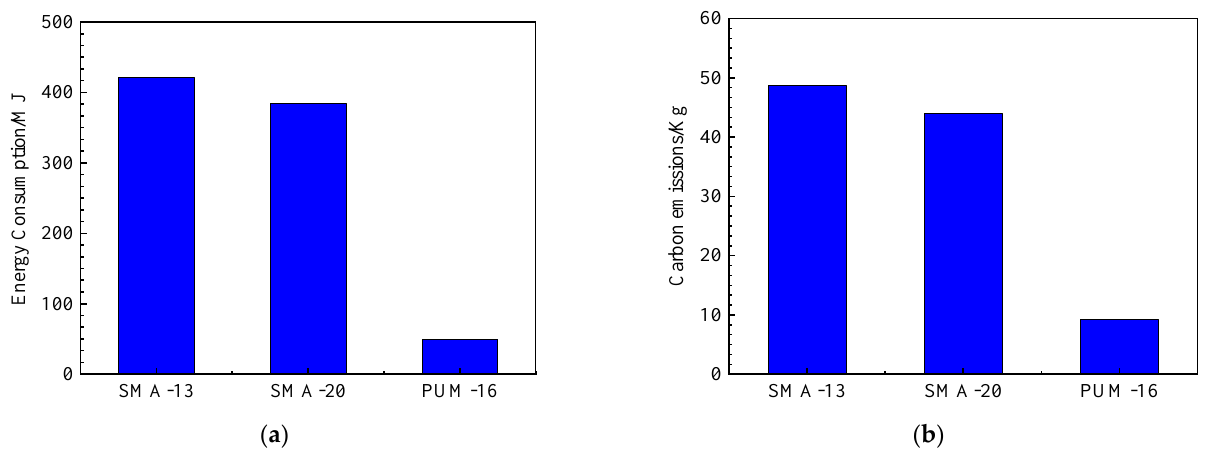
Figure 15. Energy consumption and carbon emissions of the three mixtures. ( a ) Energy consumption; ( b ) Carbon